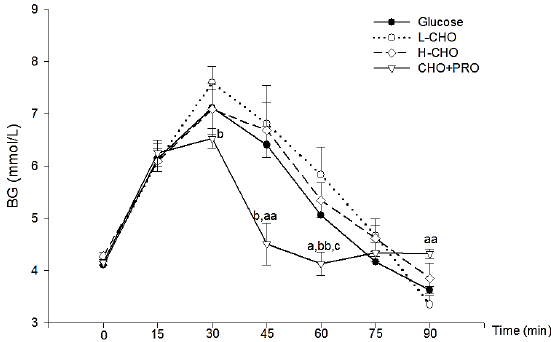
Figure 1. Blood glucose (BG) change after ingestion of different solutions. a: vs. Glucose, p < 0.05; aa: vs. Glucose, p < 0.01; b: vs. L ‐ CHO, p < 0.05; bb: vs. L ‐ CHO, p < 0.01; c: vs. H ‐ CHO, p < 0.05. CHO: